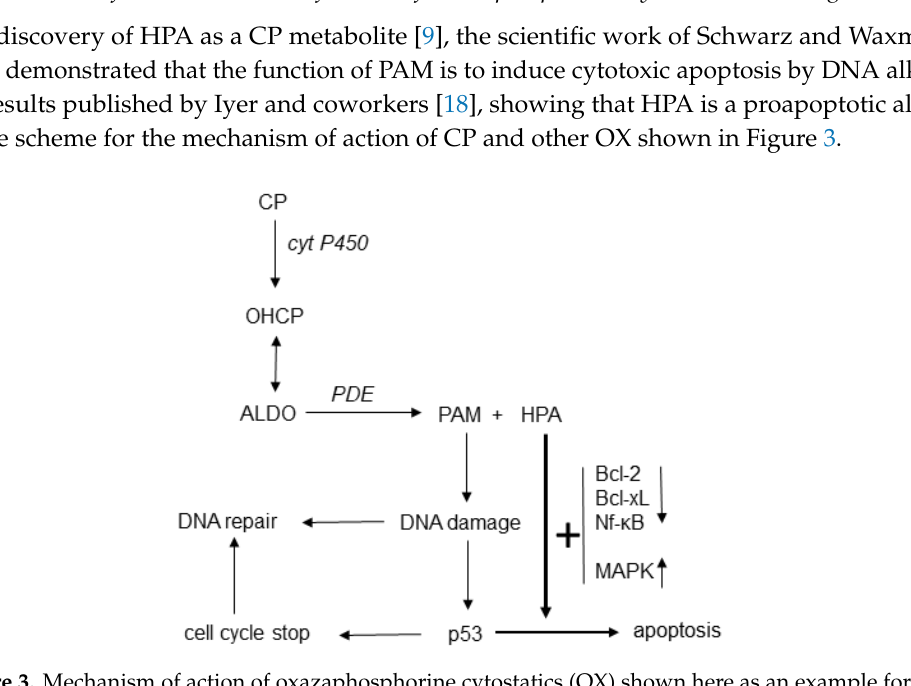
Figure 3. Mechanism of action of oxazaphosphorine cytostatics (OX) shown here as an example for CP (for details, see text).